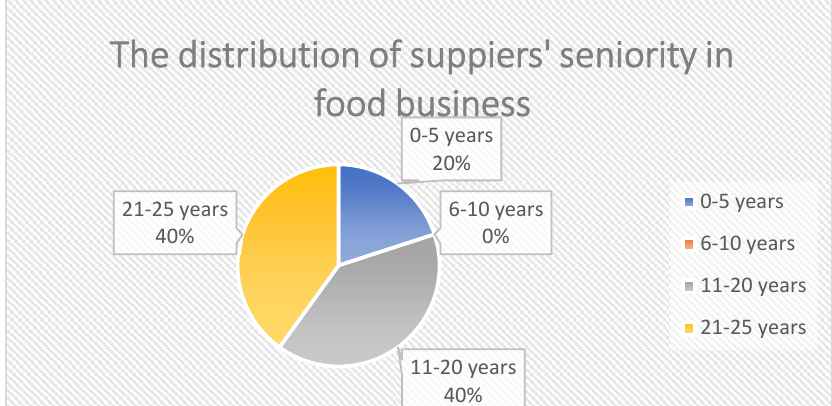
Figure 4. The distribution of supplies’ seniority in the food business.